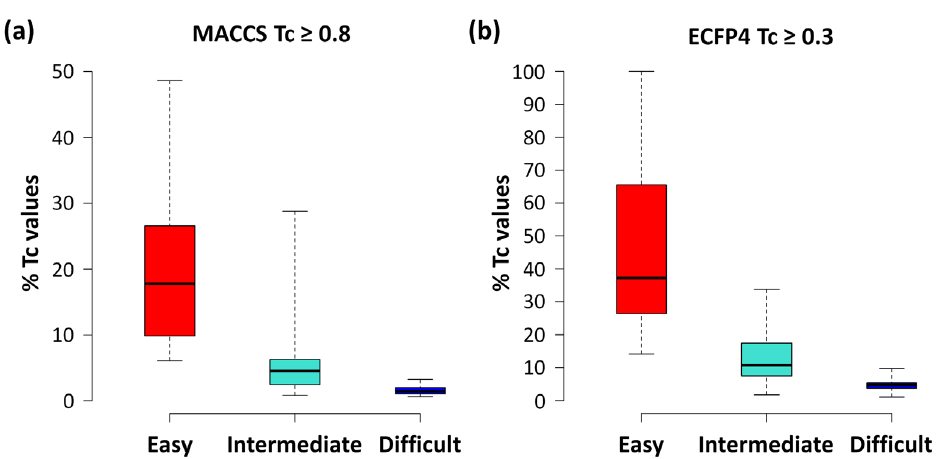
Figure 5. Distribution of similarity values in activity-relevant ranges. Box plots report the distribution of the percentage of Tc values falling into activity-relevant ranges for each category of activity classes using ( a ) MACCS and ( b ) ECFP4. A box plot gives the minimum percentage of Tc values in the activity-relevant range per category (bottom line), first quartile (lower boundary of the box), median value (thick line), third quartile (upper boundary of the box), and highest percentage of Tc values (top